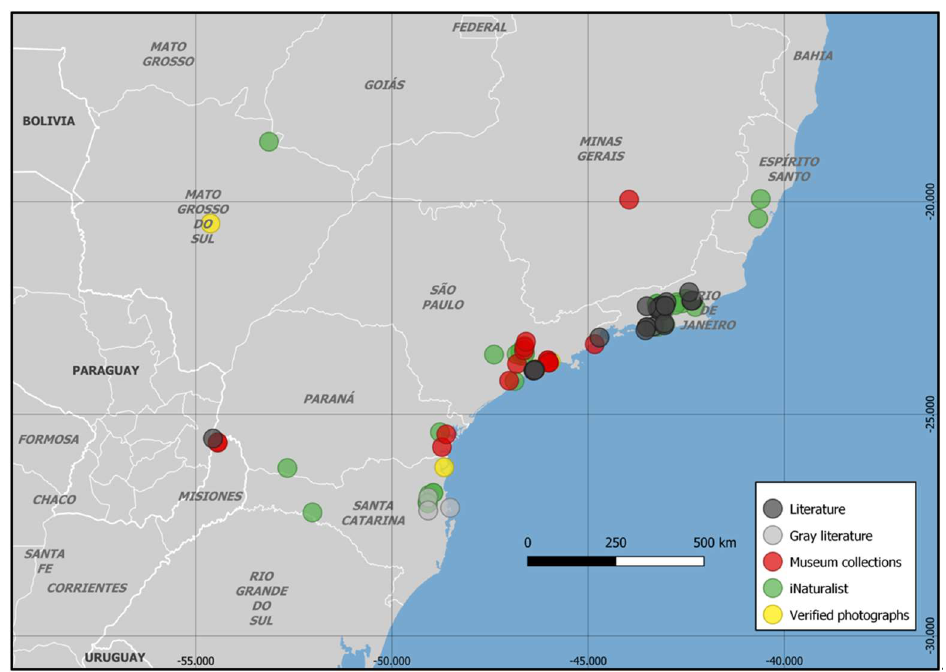
Figure 2. Map showing the distribution of Ovachlamys fulgens in Brazil according to the source of the data. The map was created with QGIS software (QGIS Development Team; https://QGIS.org, accessed on 28 September 2022) using a public domain map from Natural Earth (https://naturalearthdata.com, accessed on 28 September 2022).